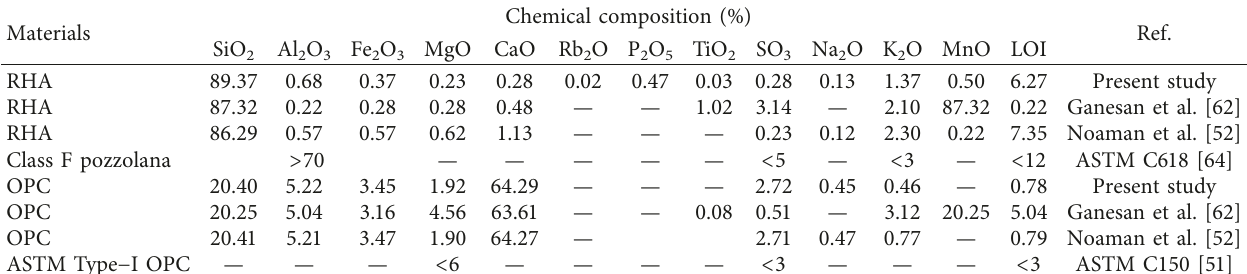
Table 4: Chemical composition of RHA and OPC.